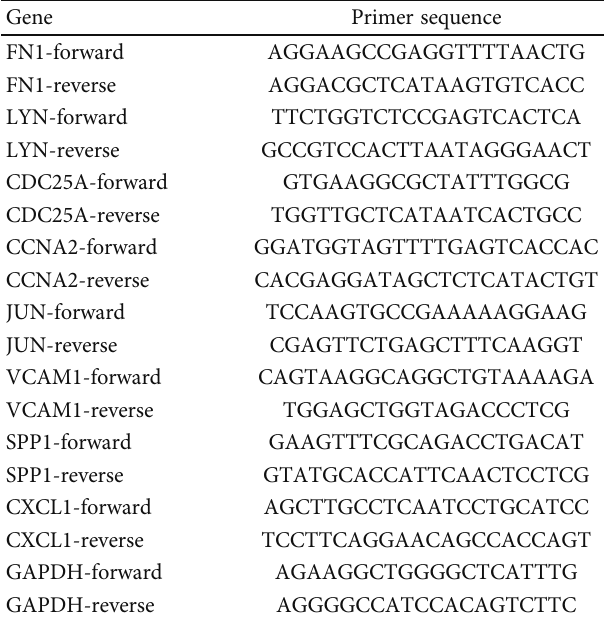
Table 1: Primers used in PCR.